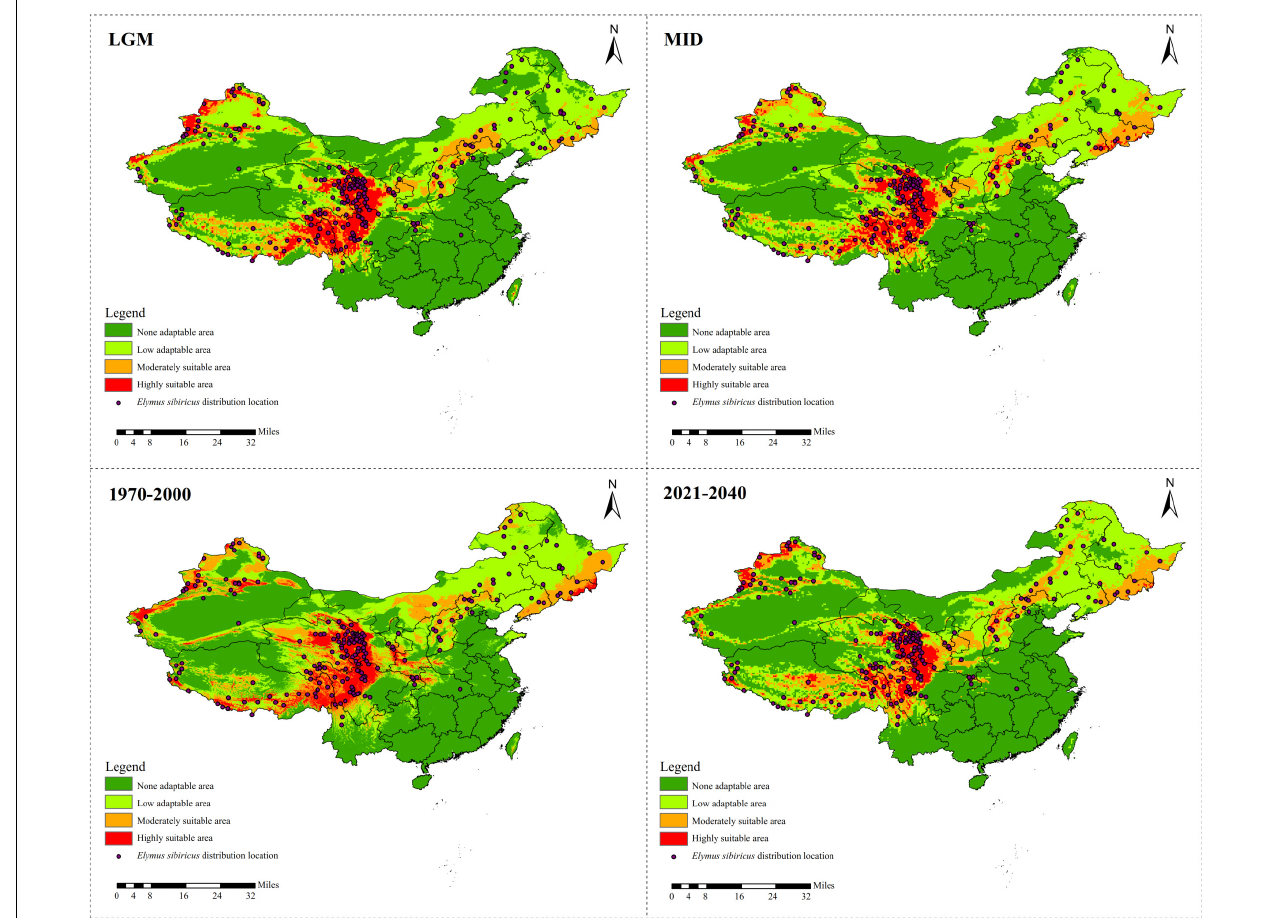
FIGURE 4 | Ecological niche modeling of Elymus sibiricus in China showing its distribution dynamics based on MaxEnt model.